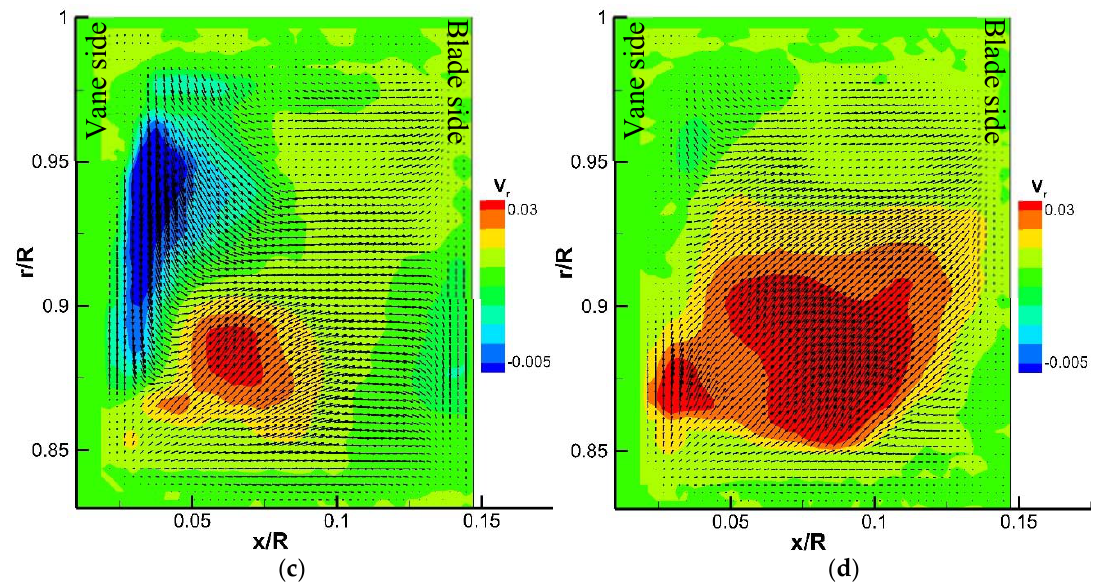
Figure 14. First order POD mode of MP7 in Case 1 and Case 2. ( a ) V a contour plot, Case 1; ( b ) V a contour plot, Case 2; ( c ) V r contour plot, Case 1; ( d ) V r contour plot, Case